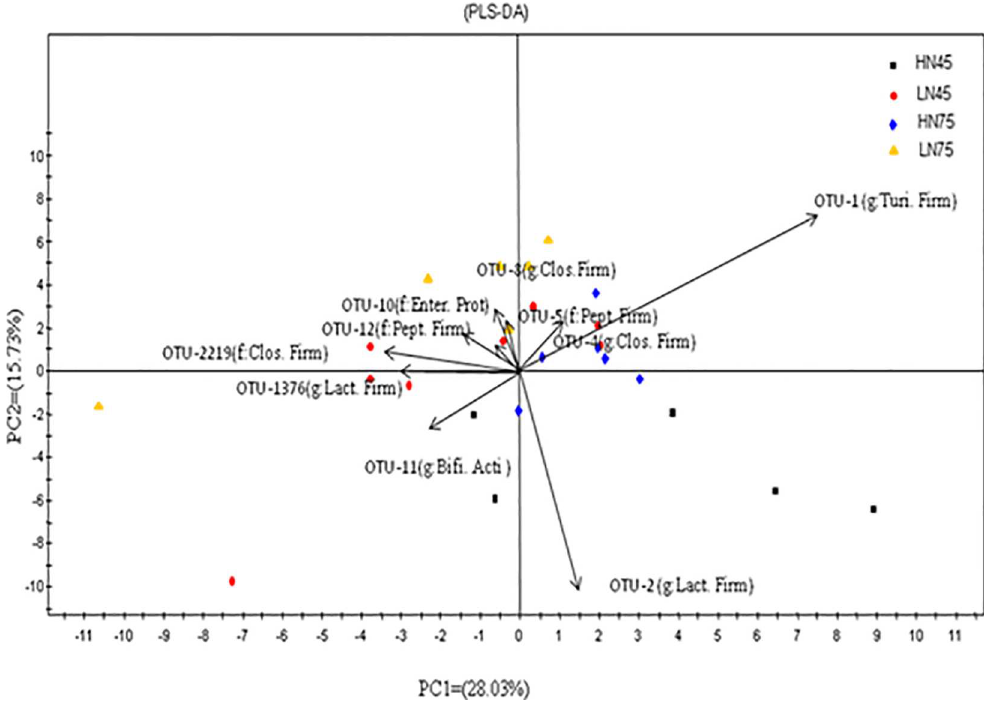
Fig 3. Principal component analysis of bacterial OTUs in ileal contents and the 10 predominant